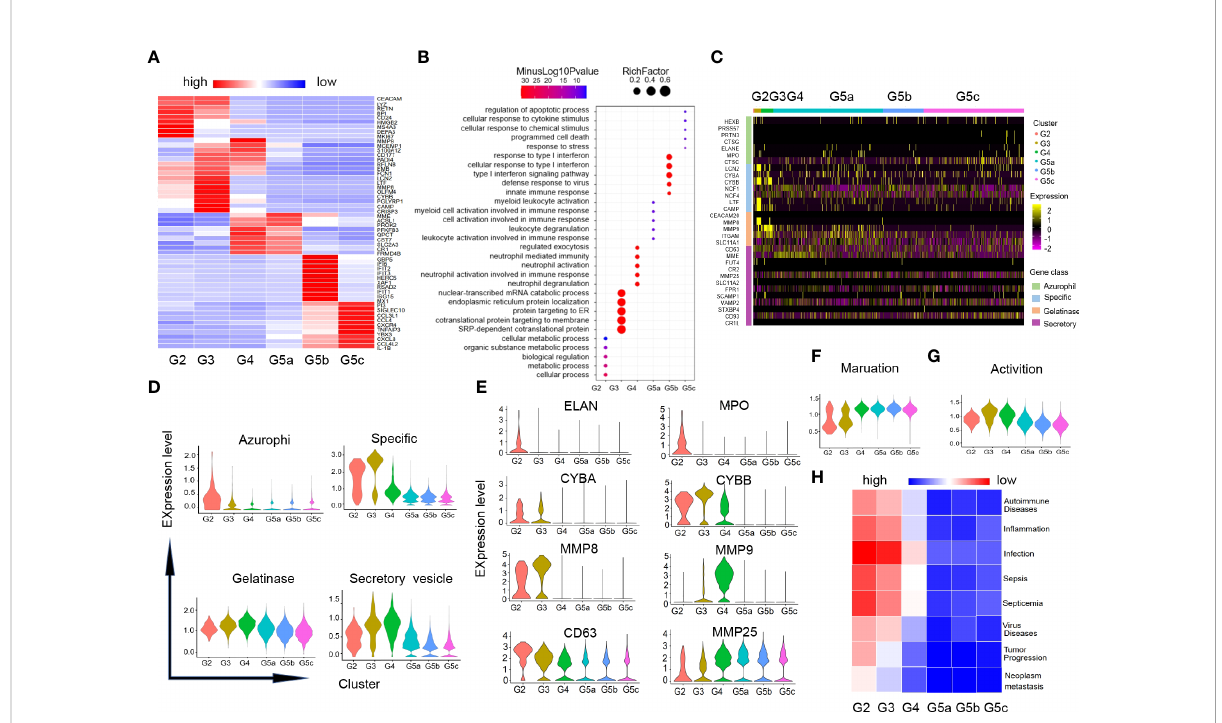
FIGURE 2 Characteristics of differentiation and development of neutrophils subgroups. (A) Heatmap of gene expression in each subgroup based on differentially expressed genes (DEGs). (B) Diagram of gene ontology (GO) about biological process (BP) analysis for genes within each subgroup. The following GO terms were shown with Benjamini-Hochberg corrected P-values <0.05 (one-sided Fisher ’ s exact test). (C) Heatmap illustrating four-level granule genes expression of neutrophils. (D) Violin diagrams of four-level granule genes function scores in each cluster. (E) Violin diagrams of representative genes related to four-level granules of neutrophils. (F, G) Violin plots of the functional scores of activation and maturation of neutrophil subsets. (H) Heatmap for correlation analysis between each subgroup and the